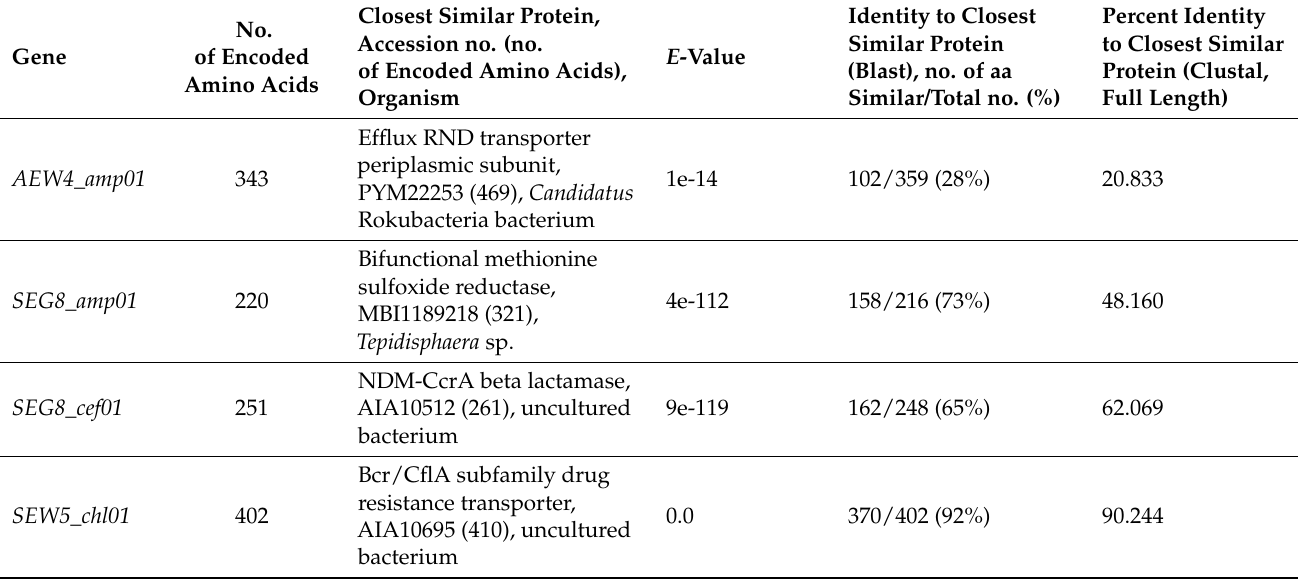
Table 2. Proteins encoded by genes associated with antibiotic resistance and their observed sequence identities.